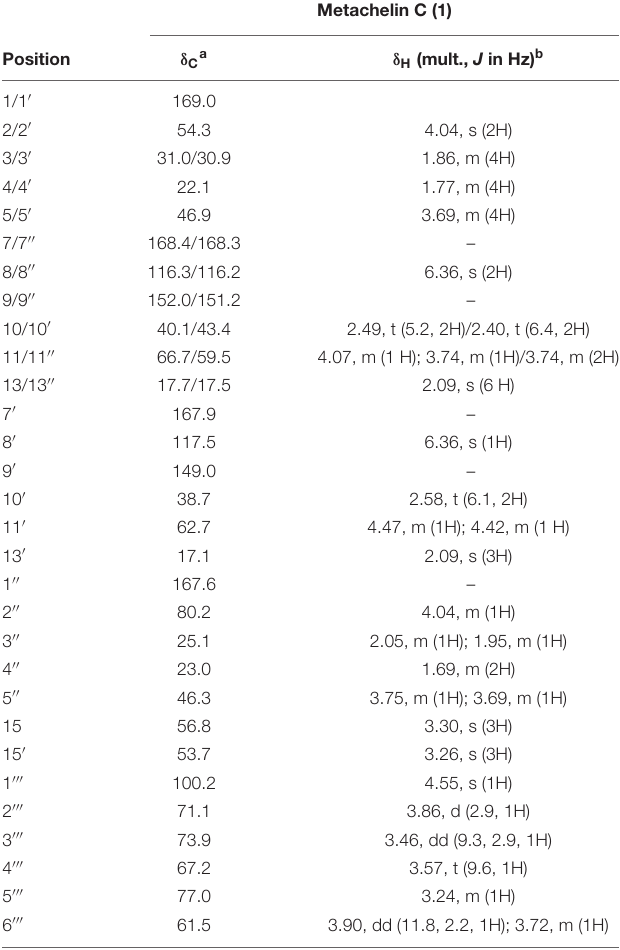
TABLE 1 | NMR spectroscopic data for metachelin C ( 1 ) in methanol- d 4 . Metachelin C